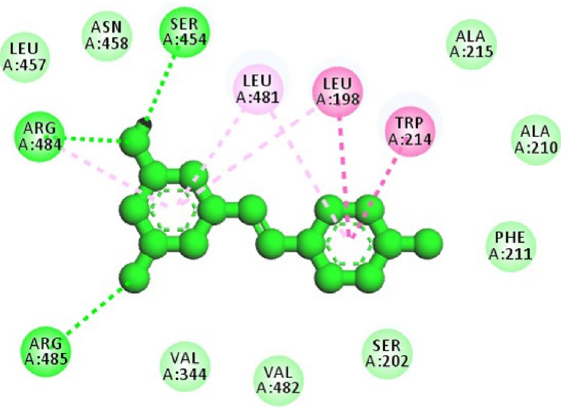
Figure 11. Two dimensional representation of the amino acid residues binding to trans- resveratrol